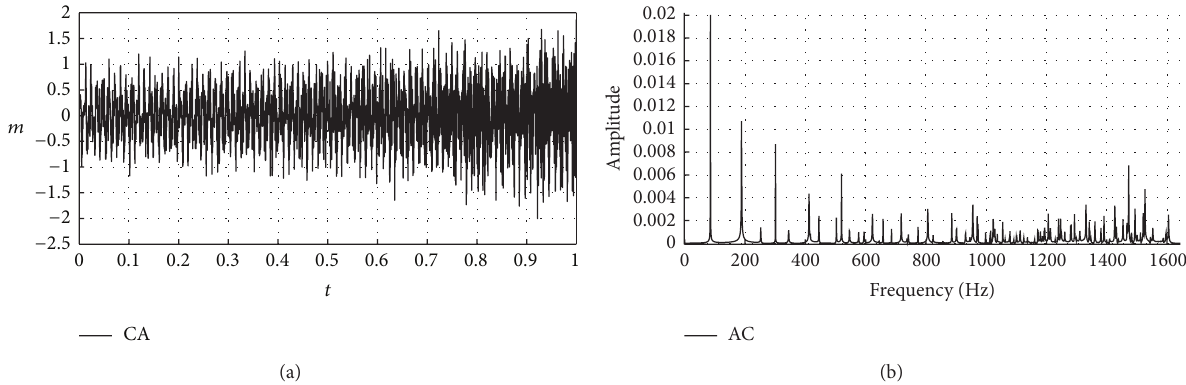
Figure 10: Graphic of the simulation of lattice’s central cell for the CA model (a); the graphic (b) shows frequency spectra for the central cell.